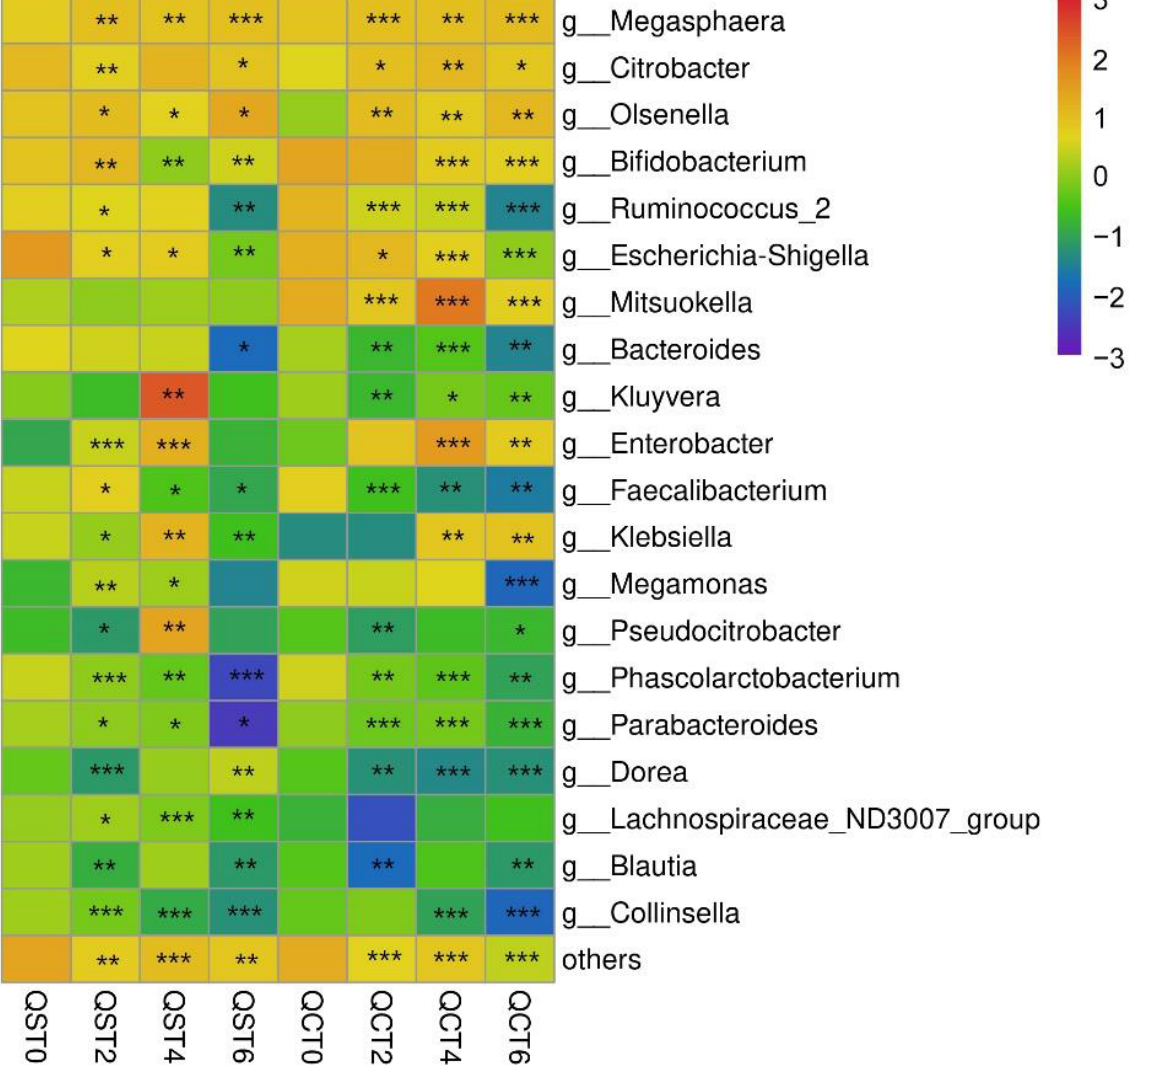
Figure 5. Heatmap of the relative abundances of bacterial genera in the intestinal mucosal microbiota (ST—aqueous extract group; CT—alcohol extract group; 0—no sample added; 2, 4, 6 denote fermentation days after sample addition; with no sample added as the control, * p < 0.05, ** p < 0.01, *** p < 0.001).